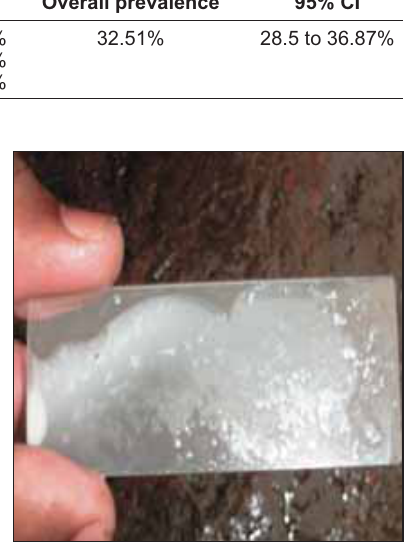
Table-1: Prevalence of SCM in dairy cows detected by three different tests Variables Tests used